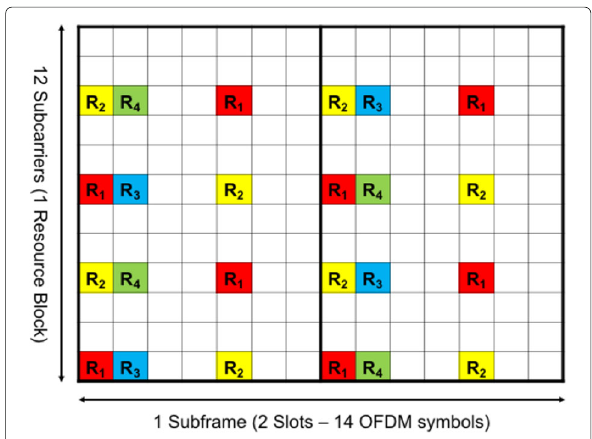
Fig. 1 LTE Cell-specific Reference Symbols. Cell-specific Reference Symbols for each antenna port in two consecutive Resource